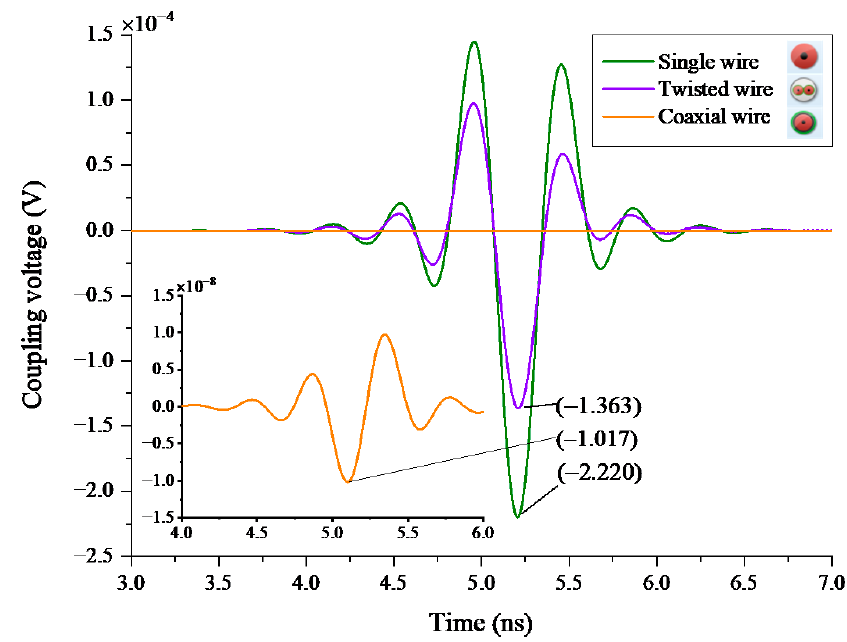
Figure 12. The structure of electromagnetic field.